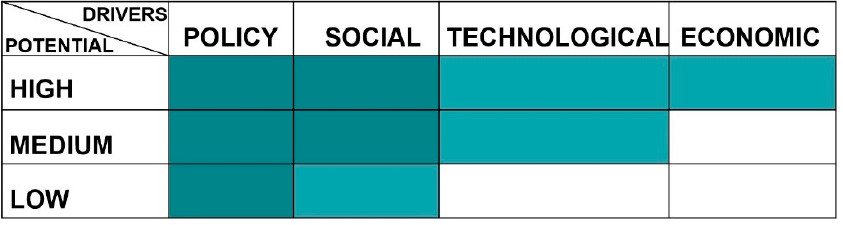
Figure A3. Presence of the main drivers for multi-use (high degree in dark blue / low degree in light blue) in relation to the classification of high/medium/low potential . Table A4. Assumptions for the decommissioning and removal of oil and gas infrastructure . SCENARIOS